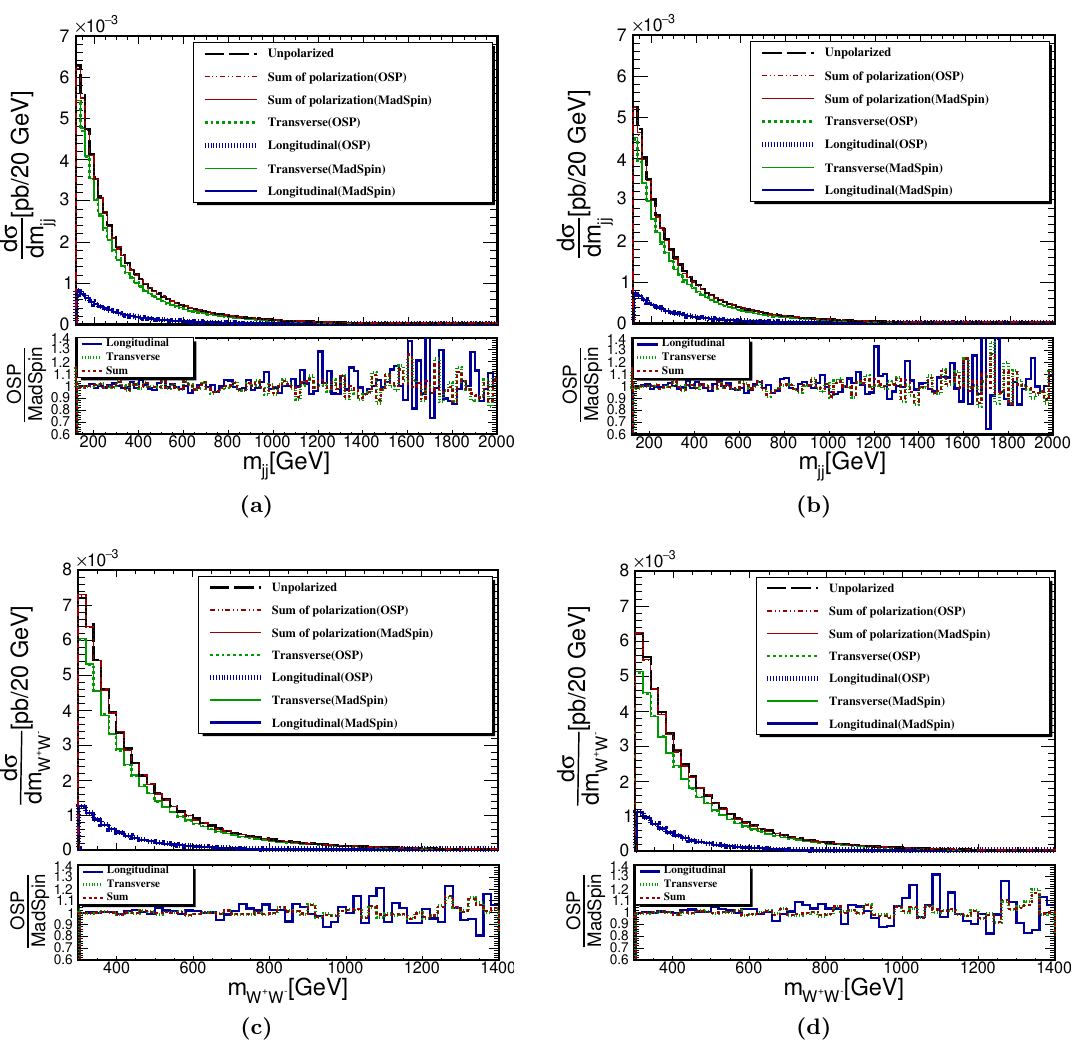
Figure 9. Same as (cid:12)gure 5 but for the mixed EW-QCD process pp ! jjW + W (cid:0)